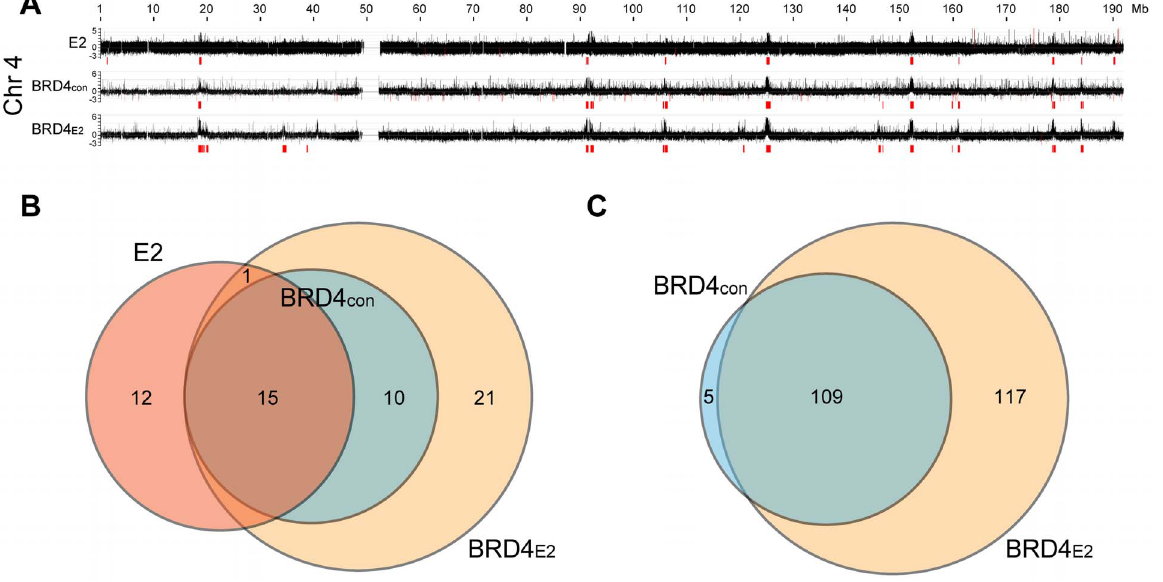
Figure 2. Profile of BRD4 binding to human chromosomes in C-33-1E2 cells. E2 expression was induced in C-33-1E2 cells (and E2 negative control cells) and chromatin was isolated with an anti-BRD4 antibody (C-term) and hybridized to 2.1M human whole genome arrays (NimbleGen). BRD4 CON represents negative control C-33 cells and BRD4 E2 represents C-33 cells expressing HPV1 E2. A. The BRD4 binding profiles are shown for chromosome 4 (the complete data set is in Figure S2). The data is aligned with the E2 binding profile for chromosome 4 from Figure 1A. Broad regions of enriched binding were defined computationally and are shown in red (the coordinates are listed in Table S2). B. Regions enriched for E2 binding (E2), and BRD4 binding in absence (BRD4 CON ) and presence of E2 (BRD4 E2 ), were analyzed and computationally identified in a subset of human chromosomes (chromosome 3, 4, 5, 21, 22, and X) as described in Methods. The overlap between the enriched regions was further calculated as described in Methods and is represented in the Venn diagram. C. Broad enriched regions of BRD4 binding in the absence (BRD4 CON ) and presence of E2 (BRD4 E2 ) were identified computationally for the entire human genome (Figure S2). The overlap between the enriched regions was calculated as described in Methods and is represented in the Venn